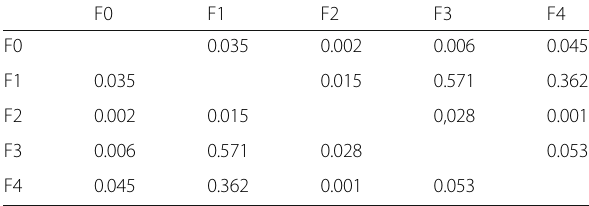
Comparison of the different stages of liver fibrosis, stratified by the METAVIR scoring system, with the corresponding p values: no (F0), mild (F1), advanced (F2), severe liver fibrosis (F3), and liver cirrhosis